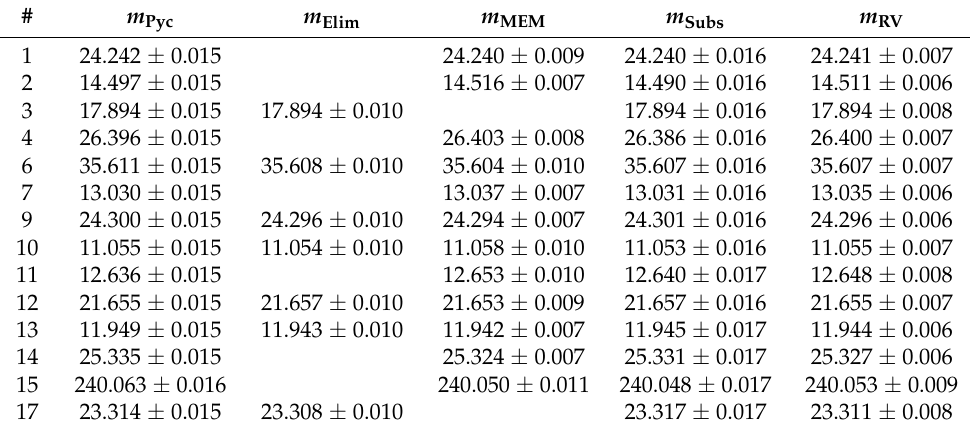
Table 5. Mass of drops and standard uncertainty